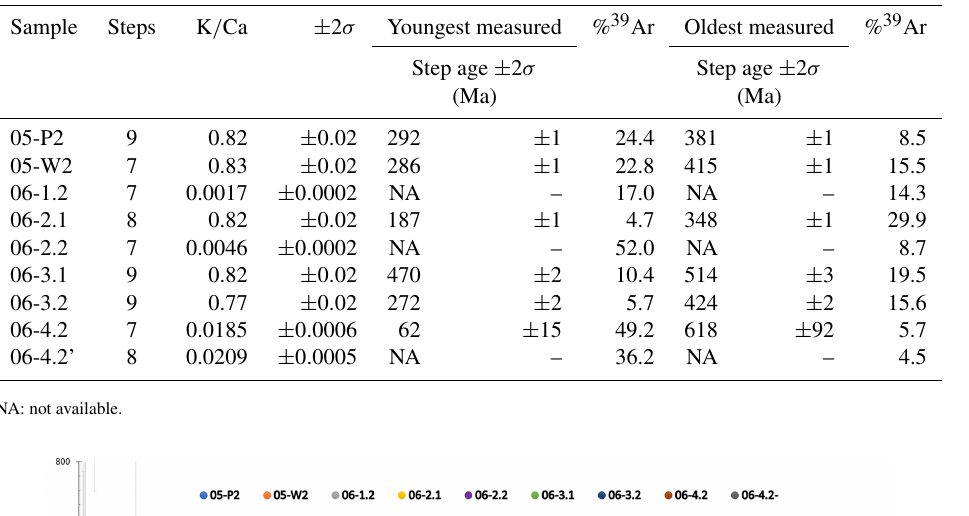
Table 1. Polyhalite 40 Ar / 39 Ar dating summary of results, Plateau Age, ± , MSWD, % 39 Ar, and inverse isochron data are not presented as no useable plateau or isochron ages were determined. Note that the single step error ages are not related to any meaningful geological events but are rather semi-quantitative numbers indicating minimum and maximum ages.